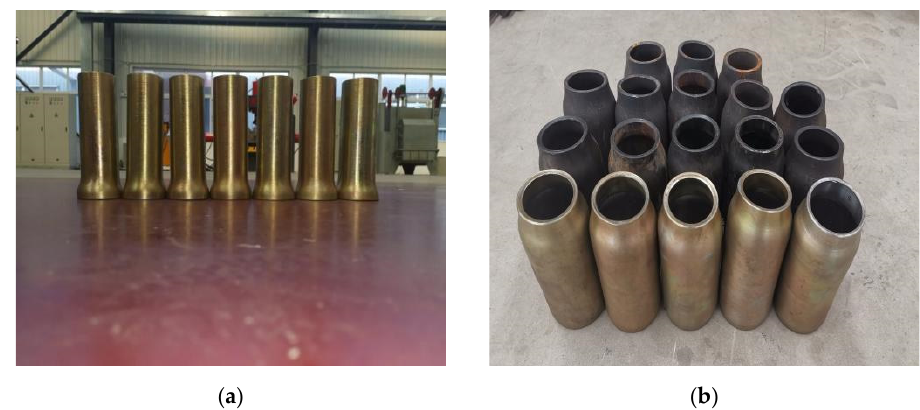
Figure 6. The energy absorbing anchor static load tensile test.